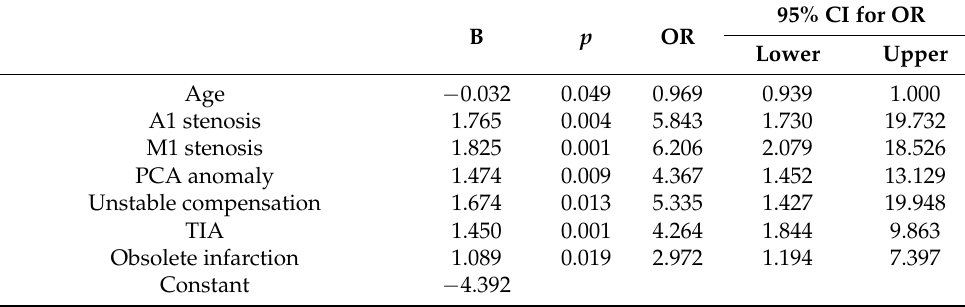
Table 2. The results of multifactor factor